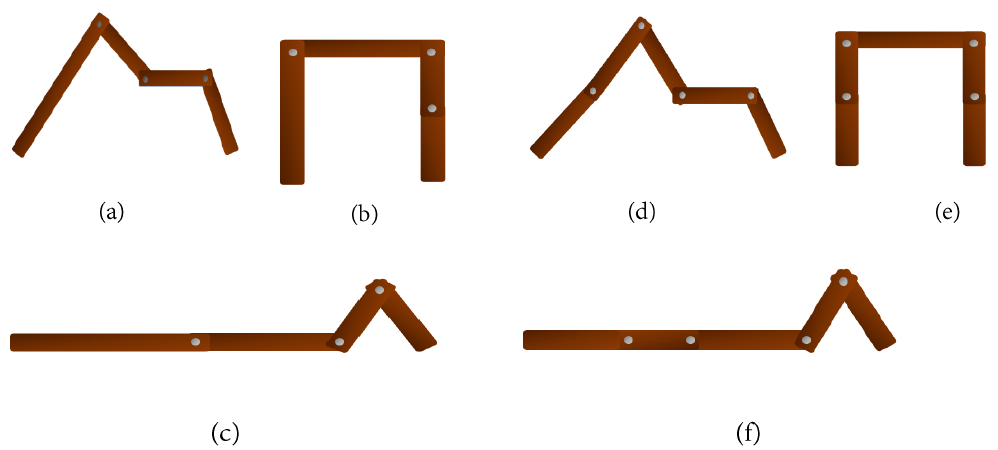
Fig. 1. Three joint chair-table-floor bed form and four joint chair-table-floor bed form respectively (side view).